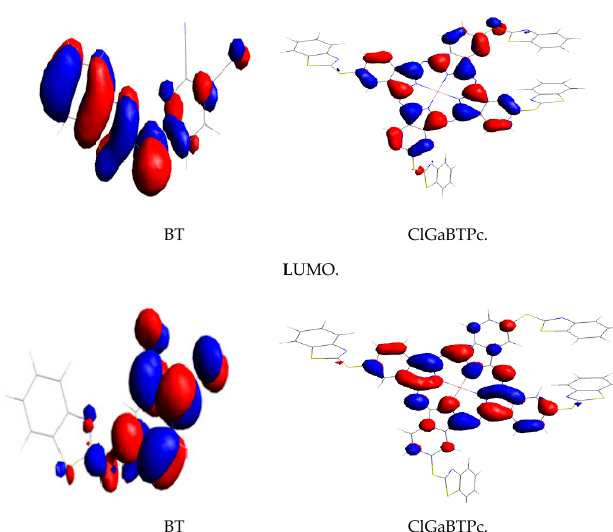
Figure 10. Gas phase optimised structures of studied molecules at B3LYP/6-31++G(d,p) level, highest occupied molecular orbitals (HOMO) and lowest unoccupied molecular orbitals (LUMO.